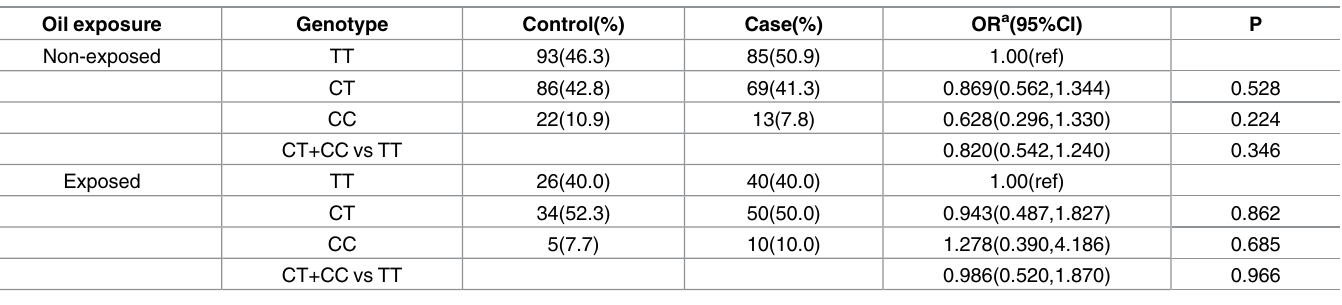
Table 4. Associations between rs2292832 and lung cancer risk, stratified by oil fume exposure. Oil